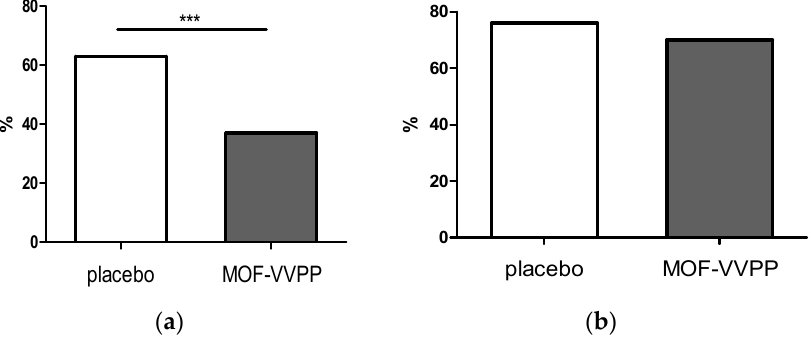
Figure 2. Prevalence of hematuria ( a ) and proteinuria ( b ) after the ibuprofen half ‐ marathon challenge measured by urine dipstick in recreational runners supplemented for 14 days with 200 mg/day monomeric and oligomeric flavanols isolated from Vitis vinifera L. seeds and Pinus pinaster L. bark (MOF ‐ VVPP). *** p < 0.001